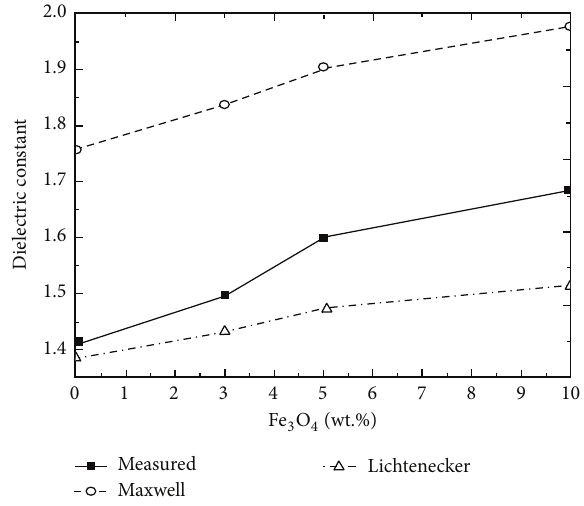
Figure 7: Actual and theoretical dielectric constants of electrospun PVdF/Fe 3 O 4 fibre webs in relation to Fe 3 O 4 nanoparticle content. Theoretical values are based on Maxwell and Lichtenecker mixture equations.